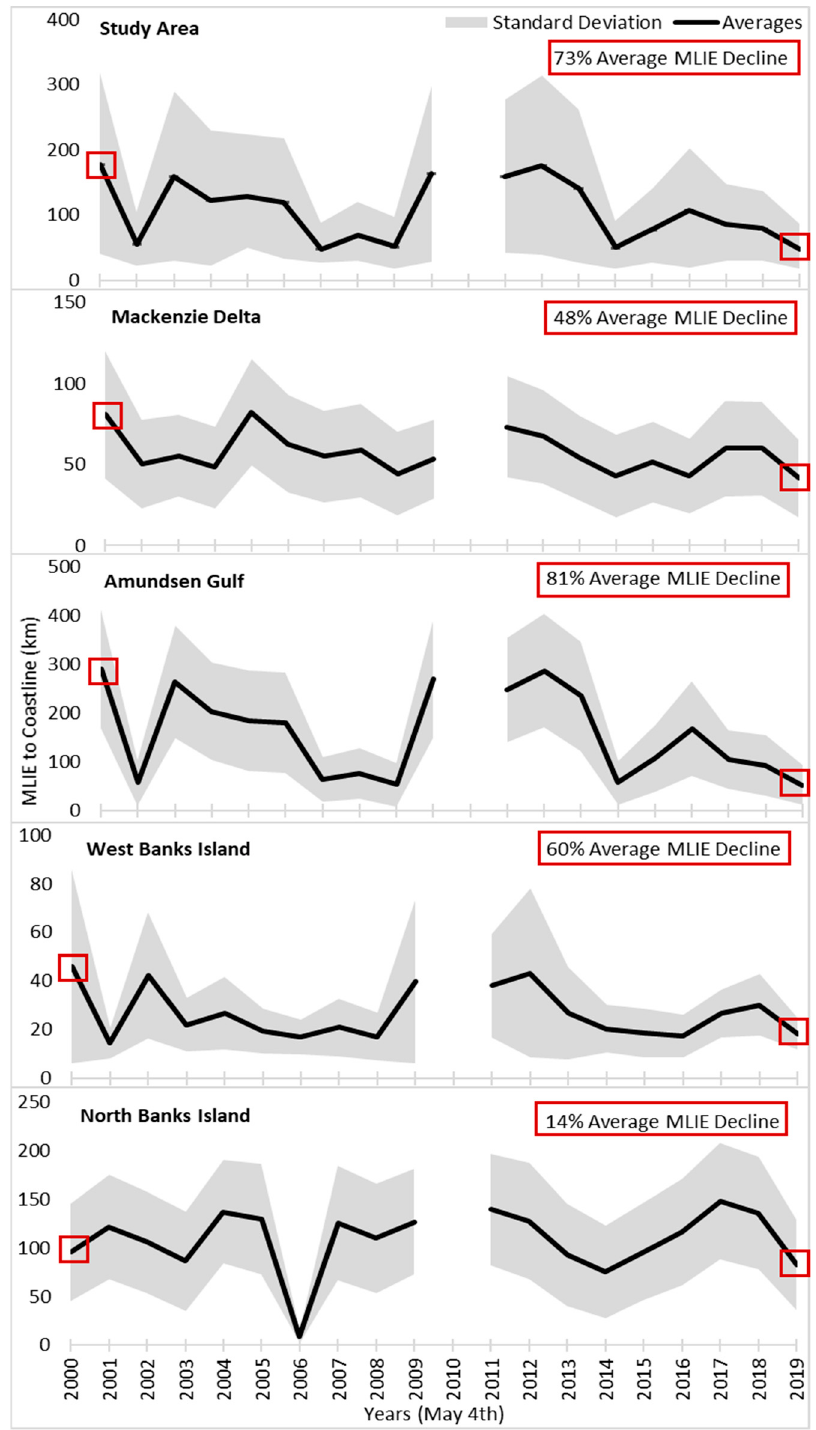
Figure 3. Average MLIE distance perpendicular from the coastline, on the 125th Day (4 May) from 2000 to 2019 per year, across the study area and regions. Red boxes outline the average % distance from coastline change in MLIE when comparing the years 2000 and 2019 directly, however the fluctuations of individual years are still identified. Greyed outline shows the variability (standard deviation) from the average MLIE across the study area and regions. Note this variability is not error; rather, it simply reflects natural variability in landfast ice position along the